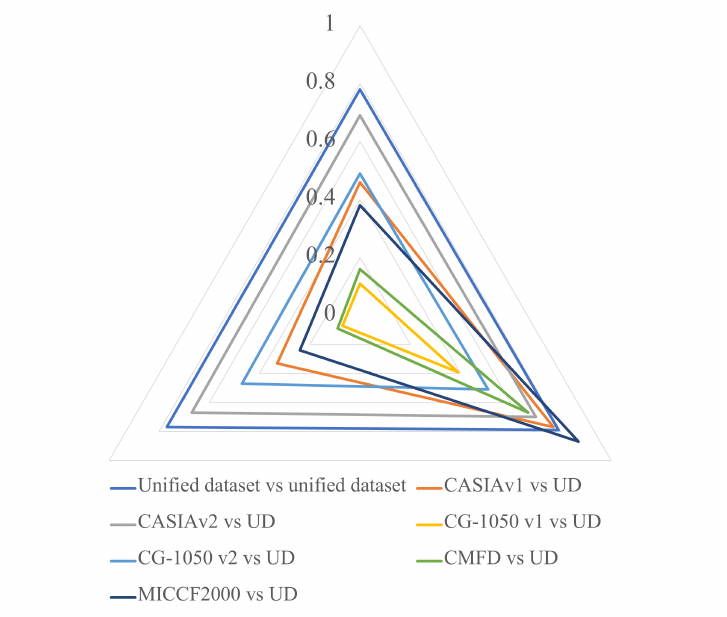
Figure 9. Ability of generalization: single dataset vs. unified dataset (UD). The triangle represents P (up), R (down, right) and F1 score (down, left).